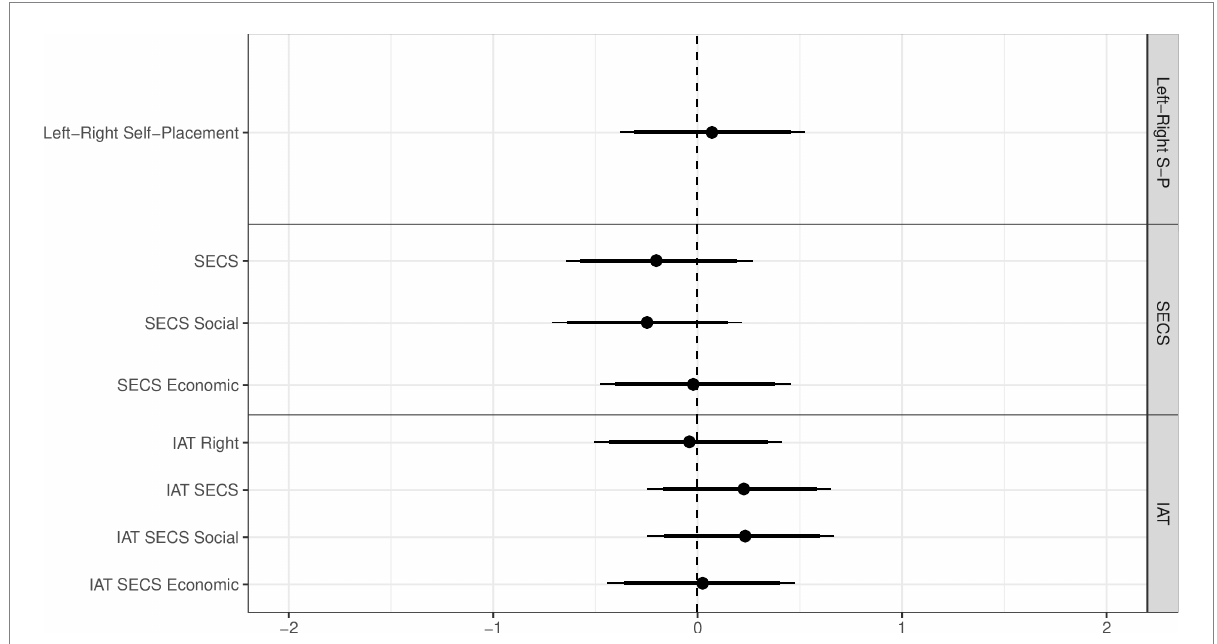
FIGURE 5 Effect of threat of shock on explicit and implicit political attitudes as Cohen’s d effect sizes. Positive values imply that average political attitudes under threat are more conservative than those under safety. Thin (thick) bars show the 95% (90%) bootstrap BCa confidence intervals. The pooled standard deviation was used for calculating Cohen’s d . IAT, Implicit Association Task; SECS, Social and Economic Conservatism Scale. N =